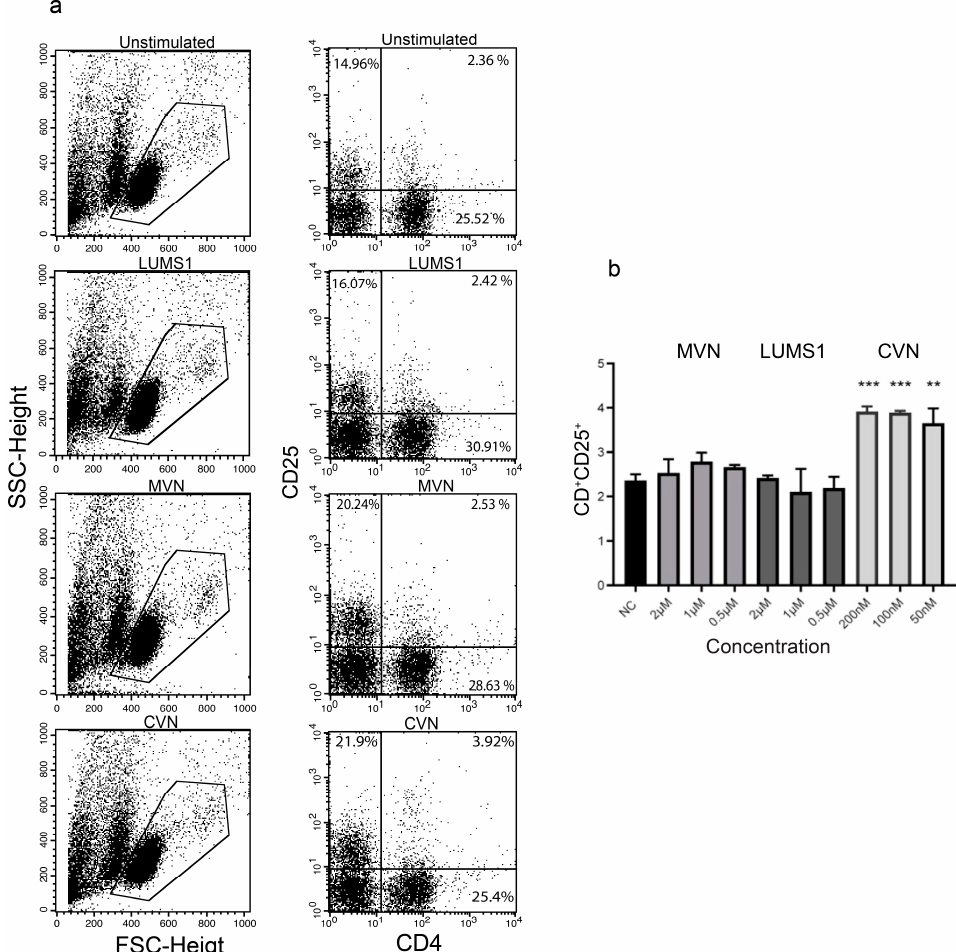
Figure 5. Effect of LUMS1 on the activation of T h cells: ( a ) Flow cytometry analysis of PBMCs to determine the population of CD4 + and CD25 + cells in freshly isolated PBMCs in response to treatment with LUMS1, MVN, cyanovirin-N (CVN). After treating PBMCs (10 6 cells/mL) with varying concentrations of LUMS1, MVN, and CVN for 72 h at 37 °C and 5% CO 2 , cells were washed with PBS and incubated with APC-conjugated anti-CD4 and PE-conjugated anti-CD25 antibodies for 30 min at 4 °C. Finally, cells were washed with PBS (2% FBS), fixed with 1% formaldehyde, and analyzed by FACS, using CellQuest software for data acquisition. Data were statistically analyzed using GraphPad Prism software. ( a ) Left panel, representative dot plots of forward scatter (FSC) and side scatter (SSC) indicating the subpopulation of cells in PBMCs; right panel, dot plots showing the relative population of cells with CD4 and CD25 activation markers. ( b ) Plot showing the percent population of CD4 + and CD25 + cells after treating with LUMS1, MVN, and CVN separately. The data represent the mean of three independent experiments and one-way ANOVA was used to compare different groups. ** p ≤ 0.01; *** p ≤ 0.001.